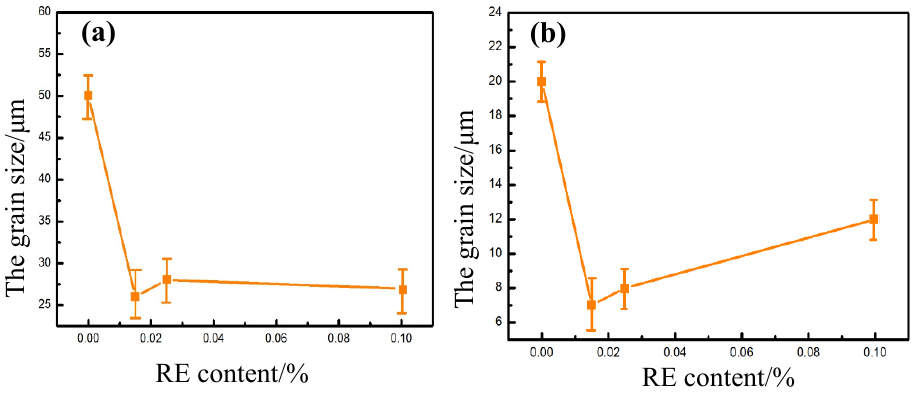
Figure 2. The grain size after heat treatment with different contents of REM ( a ) 1# ingot without REM; ( b ) 2# ingot with 0.015% REM; ( c ) 3# ingot with 0.025% REM; ( d ) 4# ingot with 0.1% REM.